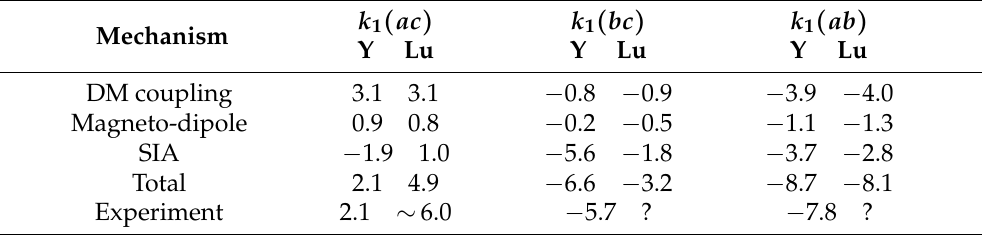
Table 5. Contributions of the main mechanisms to the first constants of the magnetic anisotropy of orthoferrites YFeO 3 and LuFeO 3 ( × 10 5 erg/cm 3 ). See text for